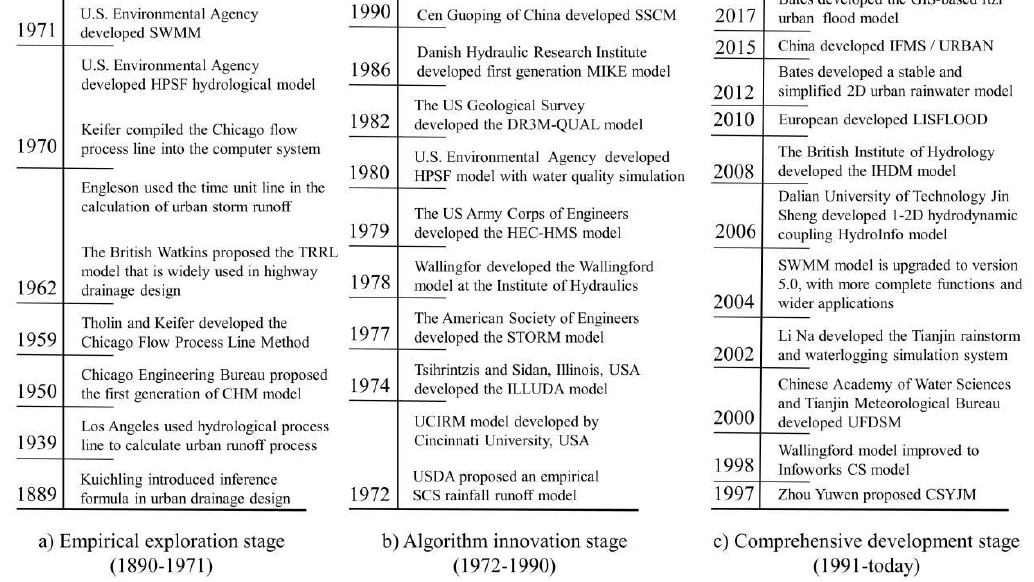
Figure 1. Urban rain flood model research progress graph [21]. (The figure is adapted from reference [21]).